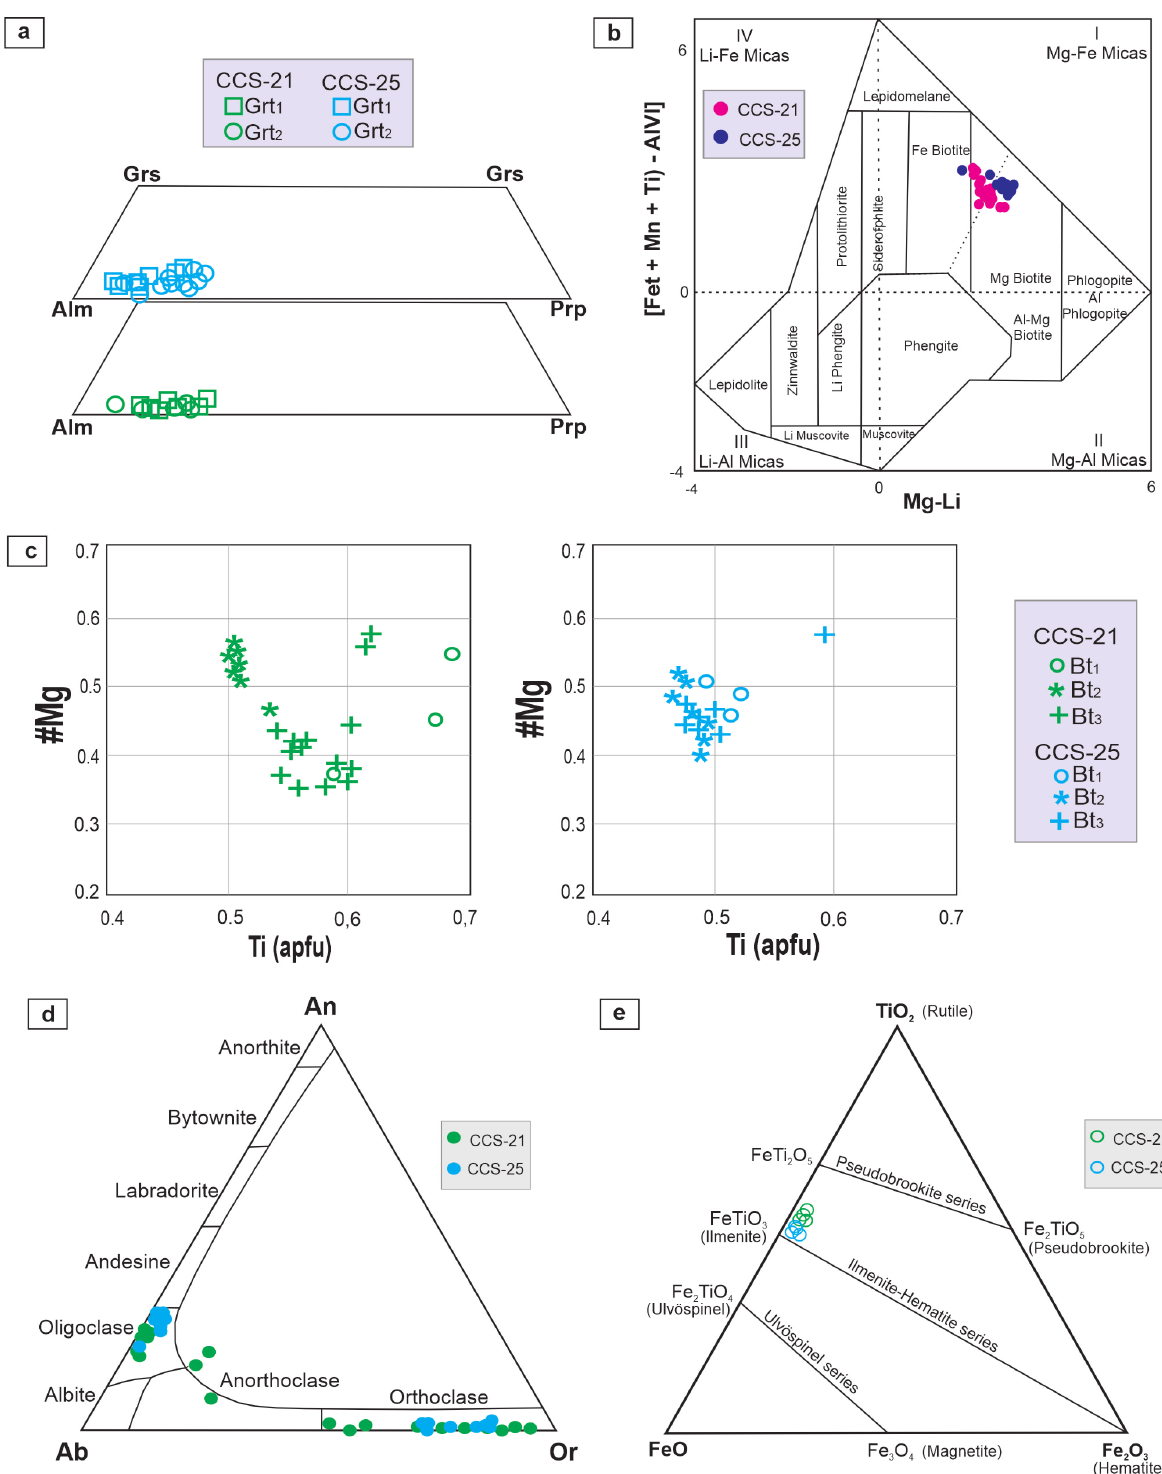
Figure 7. Mineral chemistry of the studied rocks. (a) Alm-Prp-Grs garnet ternary diagram. (b) Mica classification according to Tieschendorf et al. (1997). (c) Biotite compositions plotted on a Ti (a.p.f.u.) vs. Mg#. (d) An-Ab-Or feldspar classification diagram (after Deer et al. 2010). (e) TiO